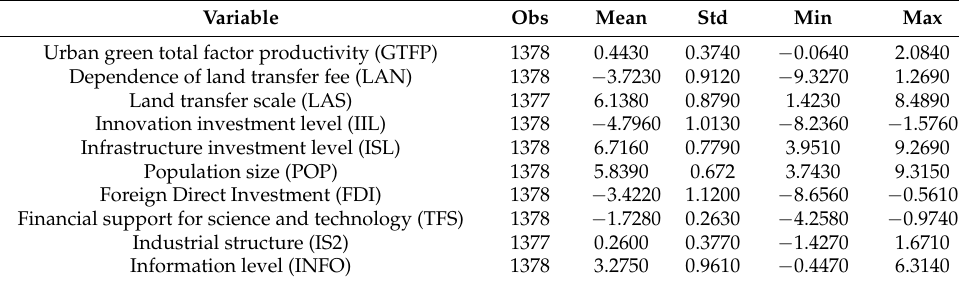
Table 4. Descriptive statistics of main variables (central region level).